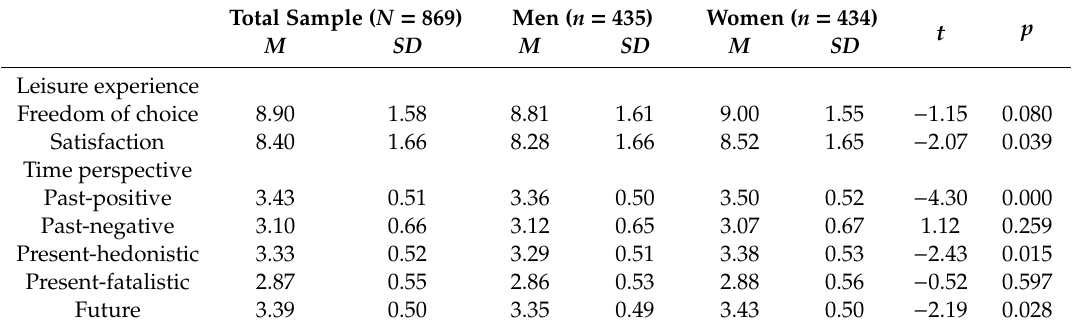
Table 2. Leisure experience and time perspective. Di ff erences according to gender. Total Sample ( N =